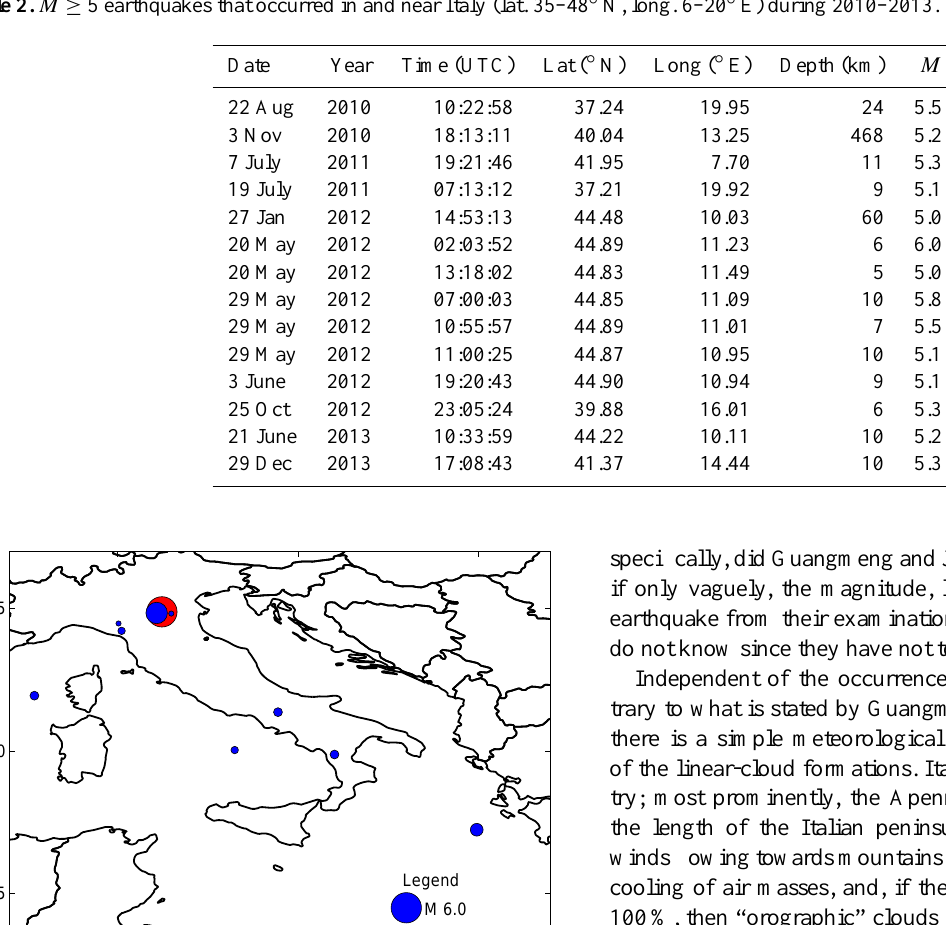
Table 2. M ≥ 5 earthquakes that occurred in and near Italy (lat. 35–48 ◦ N, long. 6–20 ◦ E) during 2010–2013.